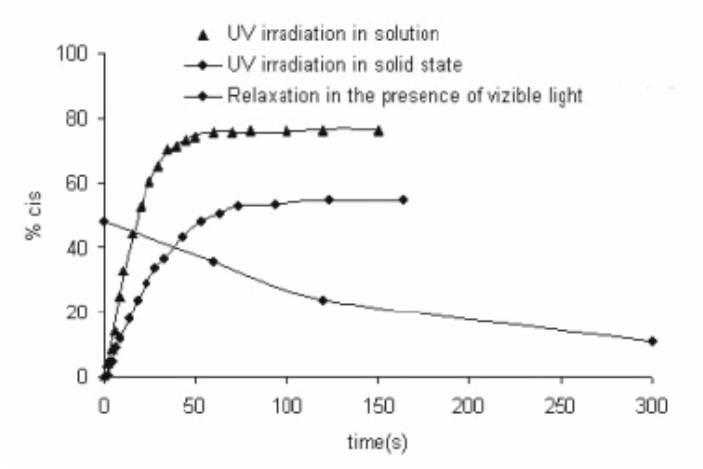
Fig. 12 The kinetic curves corresponding to the trans-cis isomerization process in solution and in solid state and cis-trans relaxation processes in solid state of Sample 5.